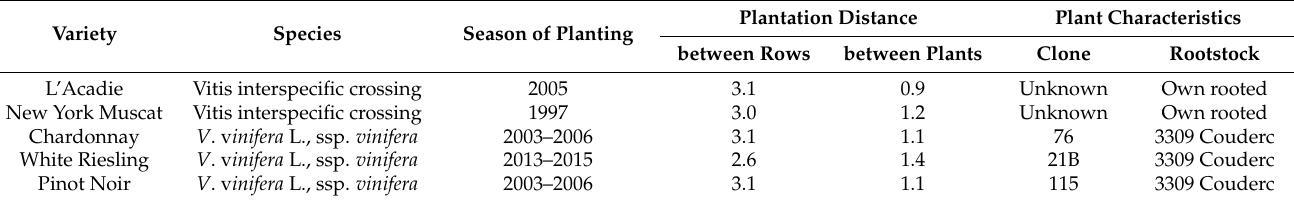
Table 1. Study site and plant material